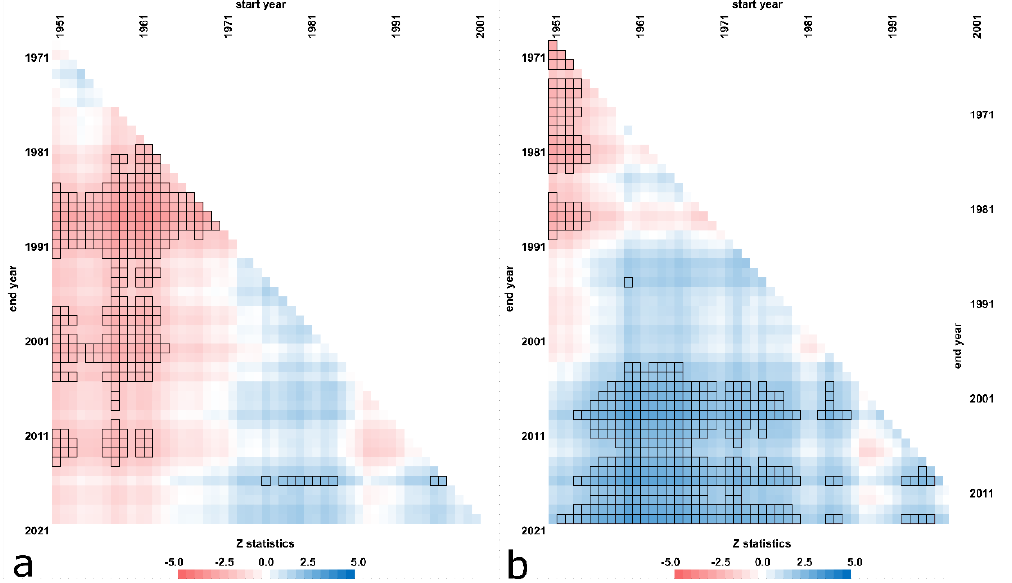
Figure 10. Multitemporal trend analysis of the time of flows below Q50% (TBQ50%) for the Gwda ( a ) and Flinta ( b ) rivers (marked fields indicate statistically significant changes at the level 0.05).